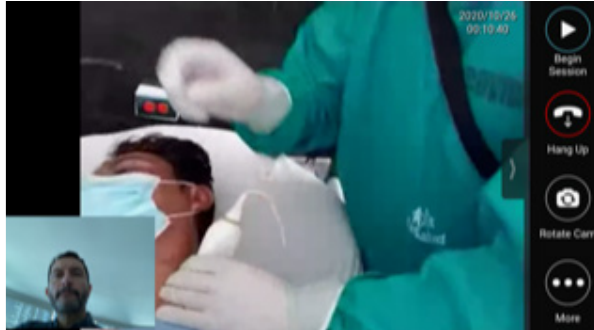
Image 1. Remote instructor visualizing the ultrasound probe positioning on the patient’s